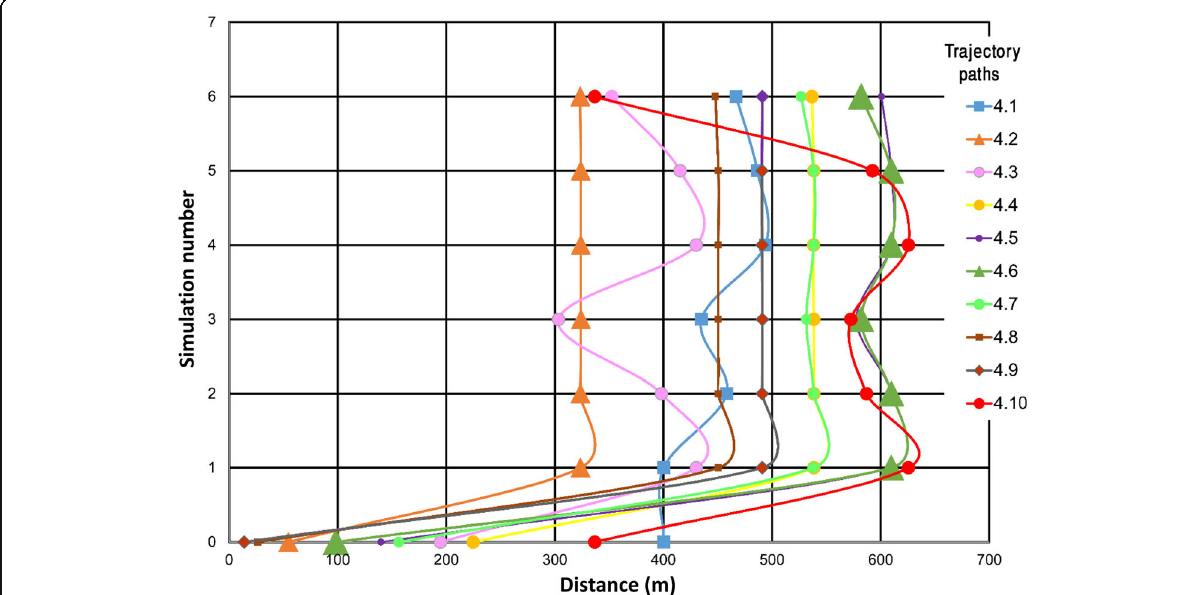
Fig. 14 Various simulation number (see Table 1 and it was decided as per different roughness values, i.e. 0 to 1) versus run-rut distance in Plot